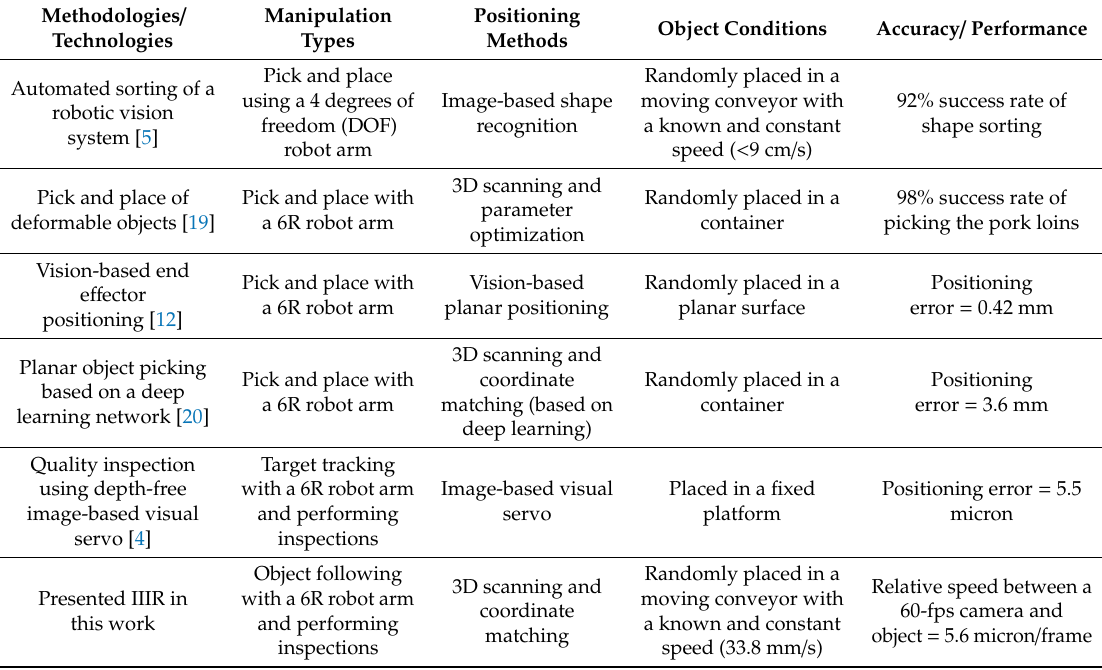
Table 3. Comparison between the proposed IIIR and other existing methods/technologies.